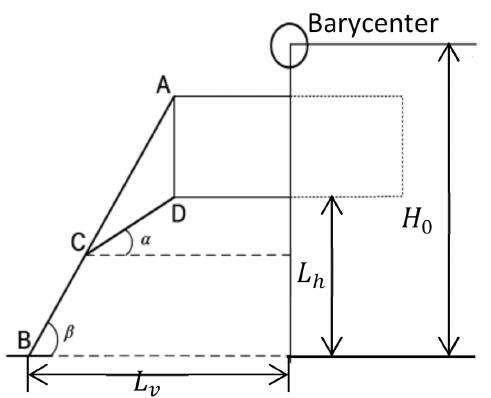
Figure 5. Compression stress as a function of compression strain for the buckypaper with density of 107.6 kg⁄m 3 under different compression